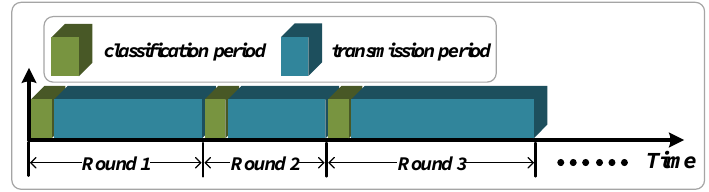
Figure 4. The round of the classification period and transmission